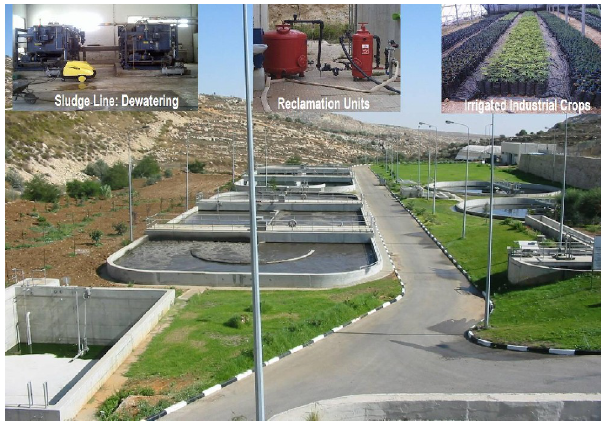
Figure 1 : Overview of Albireh wastewater treatment plant